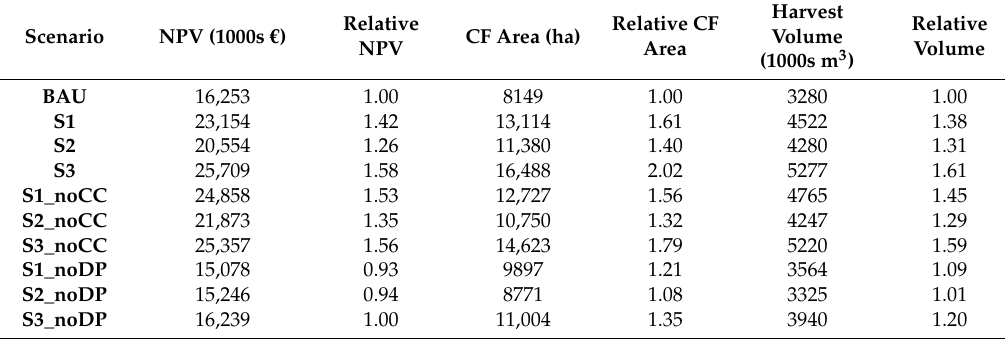
Table 8. Comparison between NPV over the 100-year planning period, relative NPV, total clearfell (CF) area, relative CF area, total extracted harvest volume, and relative harvest volume for the BAU, S1, S2, S3, noCC and noDP scenarios. Relative values are calculated using the BAU values as